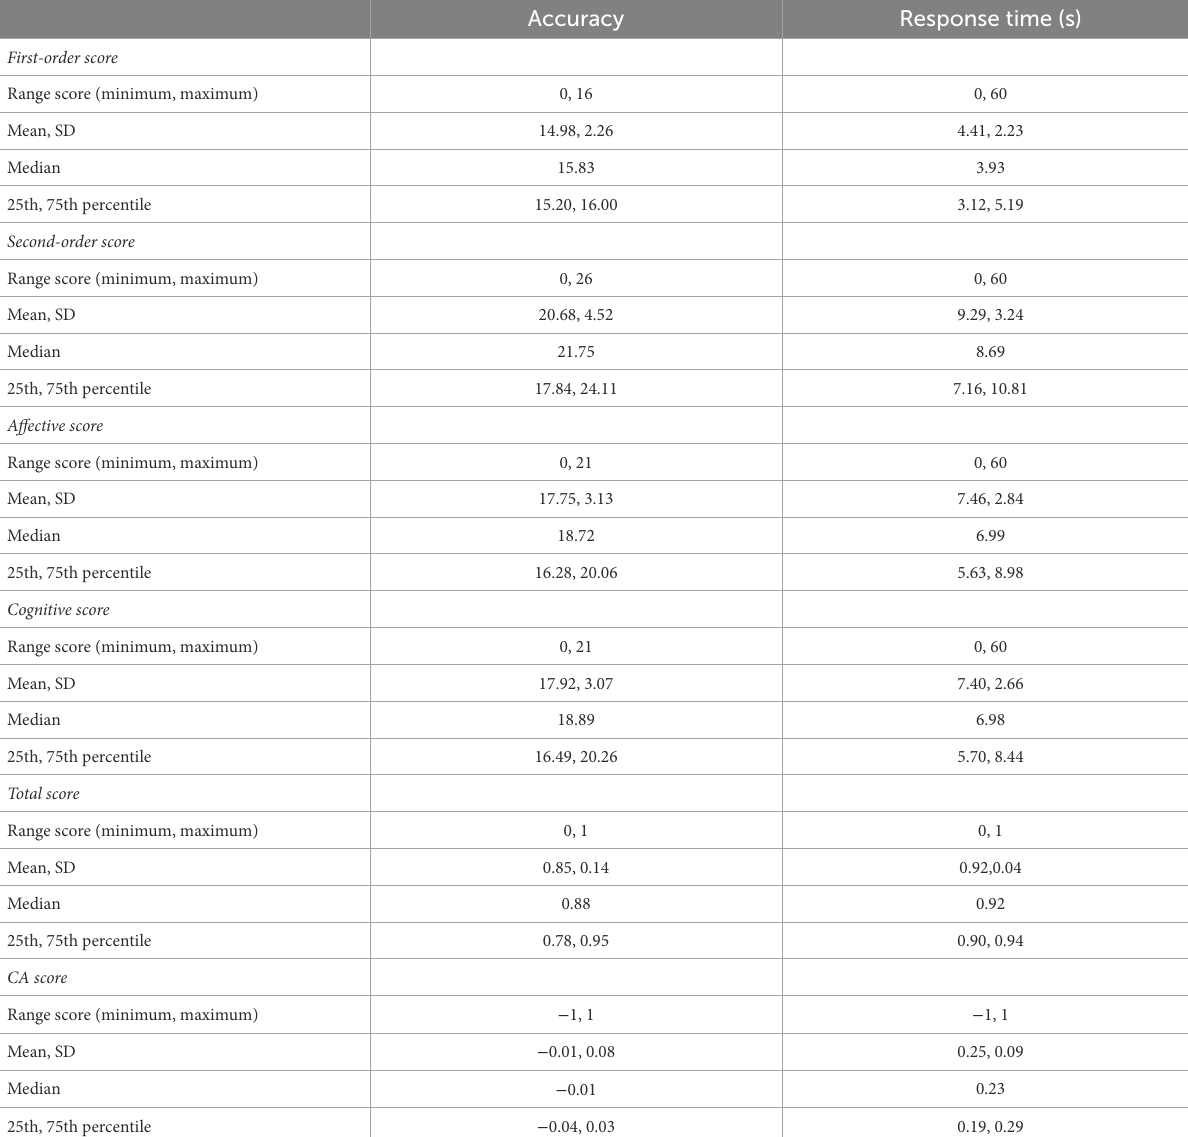
TABLE 7 Normative data of Yoni-48 item in the Italian population.